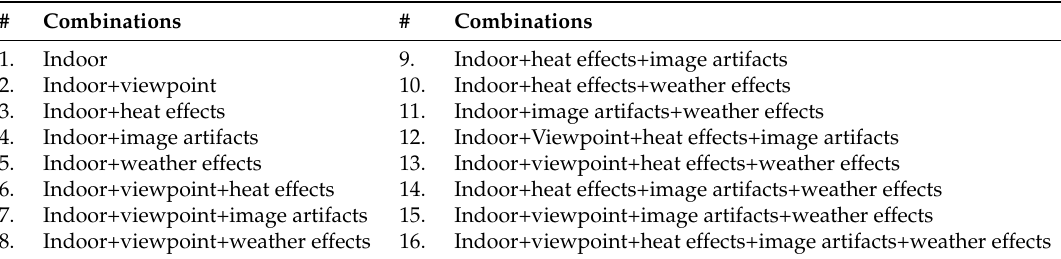
Table 3. List of combinations for